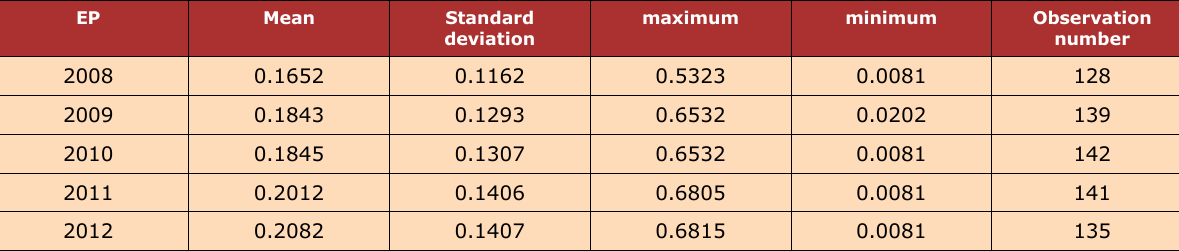
Table 1. Statistical results of corporate environmental performance in heavy-pollution